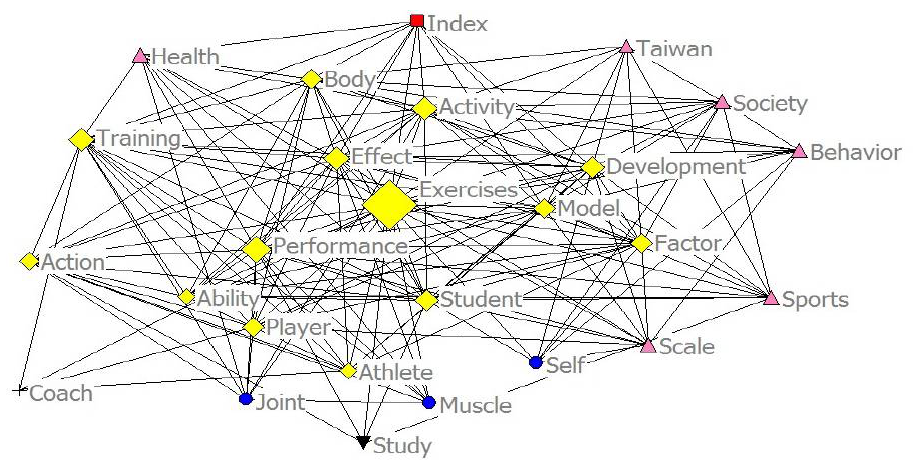
Figure 5. Network diagram for Taiwan.